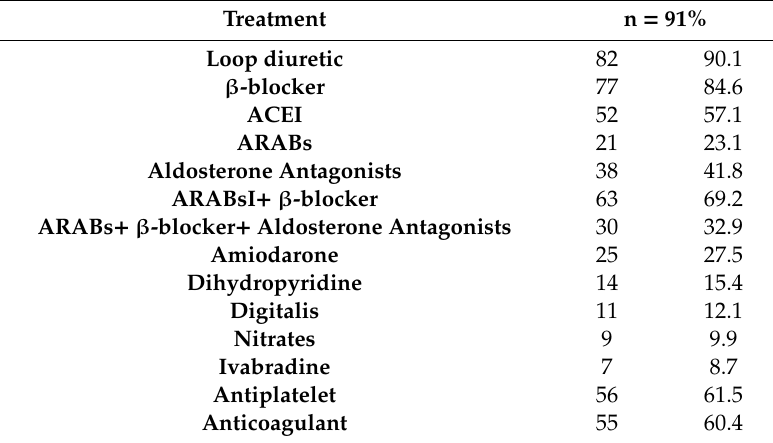
Table 2. Medical treatment upon enrollment in the PRADO-IC program.